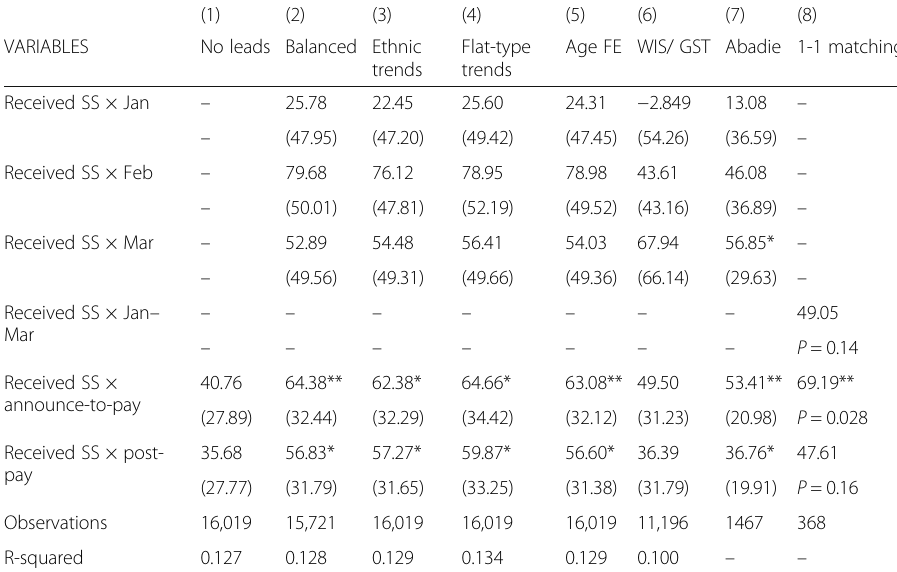
Table 27 Robustness check for impact of receiving SSS payouts on